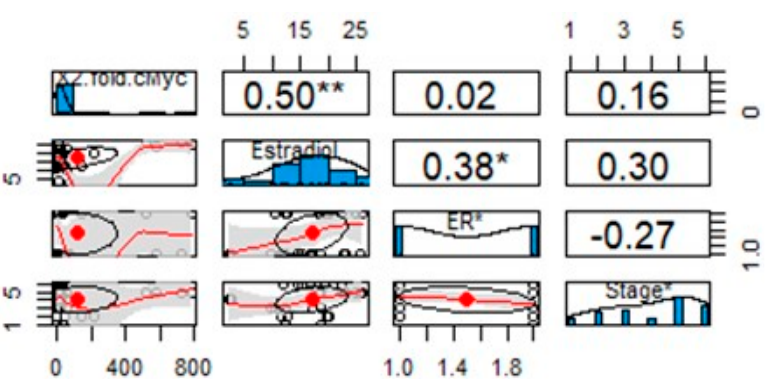
Figure 10. Multilinear regression and correlation analysis between estradiol, c-myc, ER, and stages of breast cancer. A negative correlation exists between stage and ER status. (R = − 0.54) A positive correlation exists among c-myc and estradiol (R = 0.50), and a positive correlation exists among ER and estradiol (R = 0.76). Estradiol is also positively correlated to stage of the disease (R = 0.60), while c-myc showed a weak positive correlation with stage (R = 0.32). This figure produced R 2 value, which was then converted to R correlation coefficient. * Correlation is significant at 0.05 level (two tailed) ** Correlation is significant at 0.01 level (two tailed).